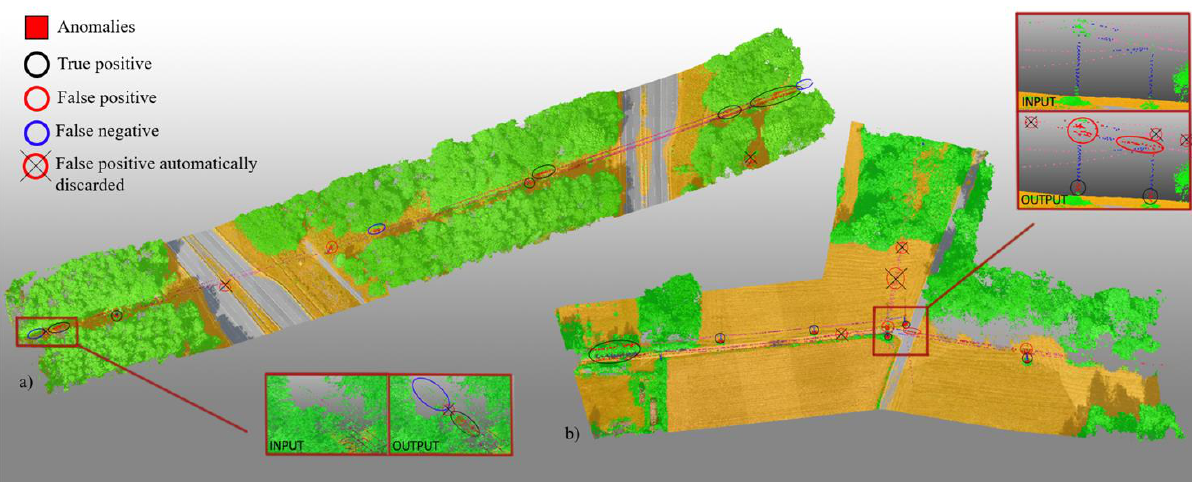
Figure 8. Results of the anomalies detected by the developed procedure and classified as: correct anomalies (true positive), false alarms eliminated (false positive automatically discarded), false anomalies not eliminated (false positive) and non-detected alarms (false